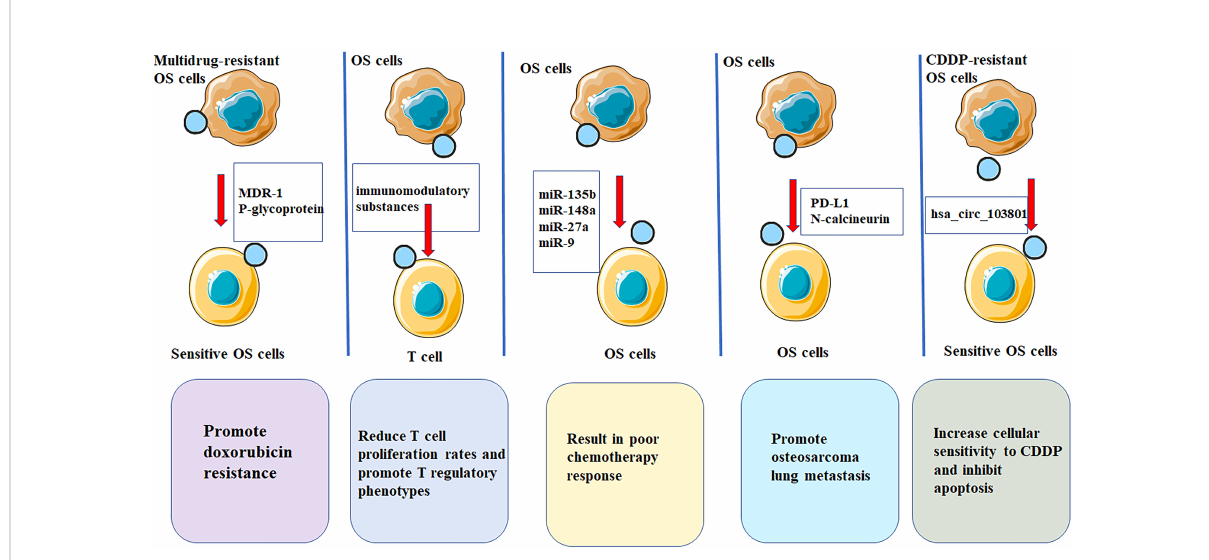
FIGURE 2 EVs have potential applications in treatment of OS. EVs are multifunctional nanostructured carriers which can be used as drug delivery systems with low immunogenicity as well as high biocompatibility and ef fi cacy. OS-derived EVs contain immunomodulation properties that signi fi cantly reduces T cell proliferation rates and promote T regulatory phenotypes, thereby promoting OS progression. OS cases showing low chemosensitivity in patients showing favorable chemosensitivity. miR-9, miR-27a, miR-135b and miR-148a show marked up-regulation within serum EVs of OS patients. OS cells could promote osteosarcoma lung metastasis by releasing EVs that contained PD-L1 and N-calcineurin. EVs from cisplatin-resistant (CDDP)-resistant OS cells decreased P-glycoprotein and MDR-associated protein 1 levels in MG63 and U2OS cells, increases cellular sensitivity to CDDP and inhibits apoptosis through